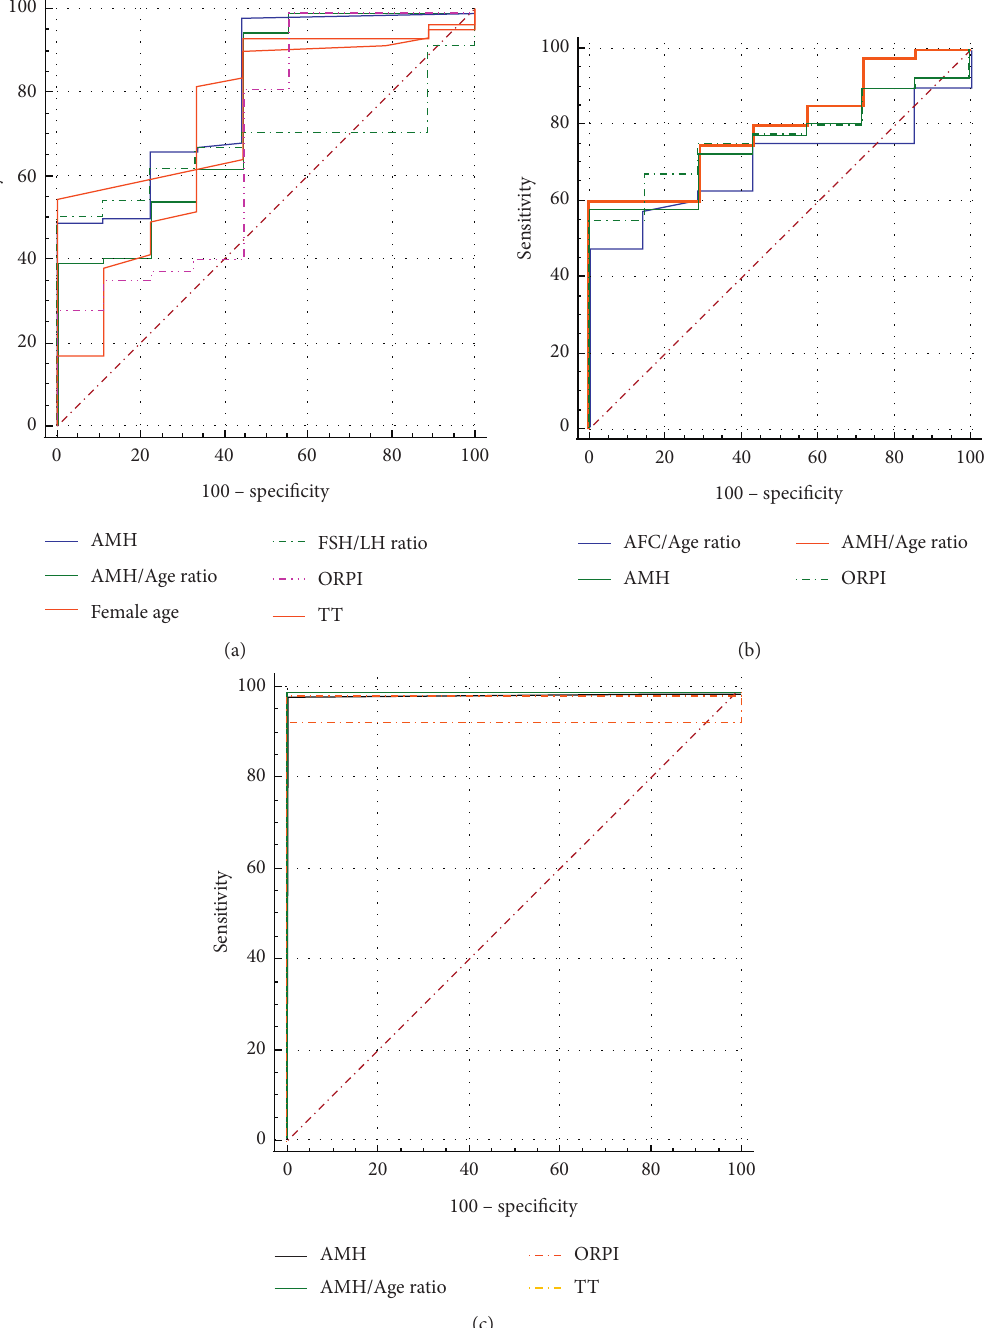
Figure 2: The comparison of variables evaluated oocyte retrieval on ROC curves. (a) ROC curves of variables evaluated oocyte retrieval in subjects aged 21–46 years. (b) ROC curves of variables evaluated oocyte retrieval in subjects aged 21–34 years. (c) ROC curves of variables evaluated oocyte retrieval in subjects aged 35–46 years. ROC curve, receiver operating characteristic curve; AFC, antral follicle count; AMH, anti-M¨ullerian hormone; FSH, follicle-stimulating hormone; LH, luteinizing hormone; ORPI, ovarian response prediction index; TT, total